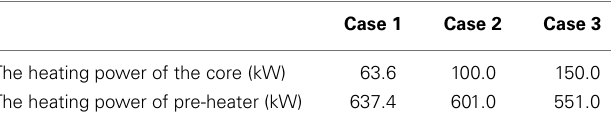
Table 3 | Sensitivity analysis on power distribution